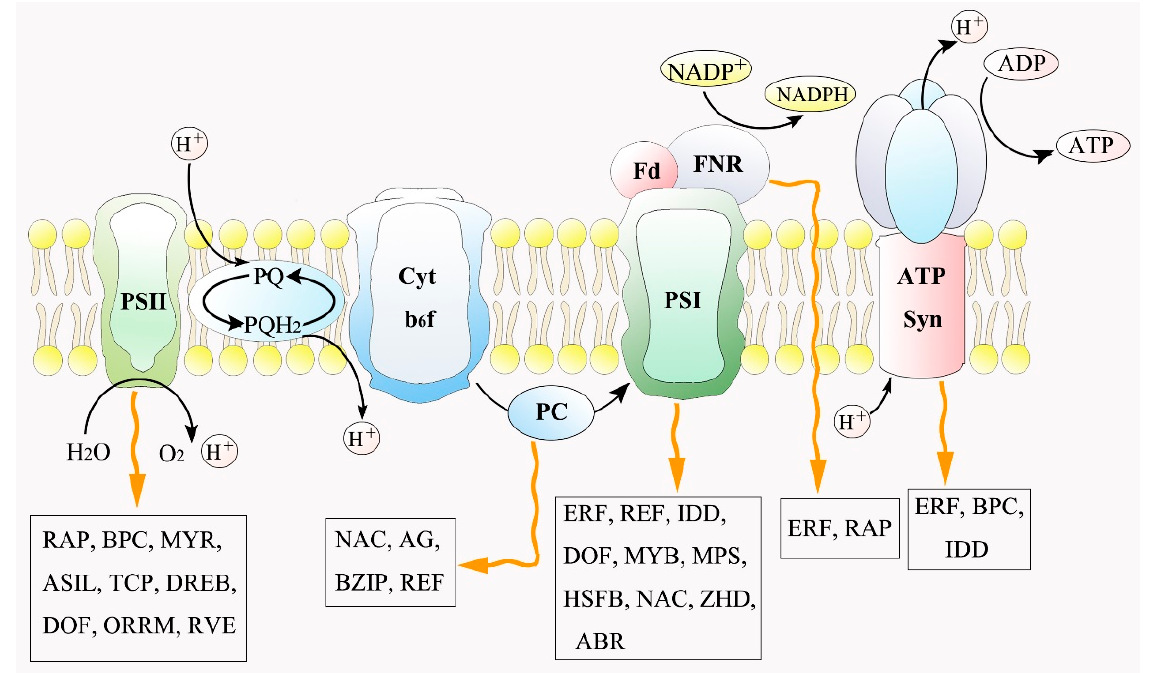
Figure 6. Schematic diagram of TFs involved in regulating photosynthetic process under salt stress. (TFs were screened based on co-expression network analysis).